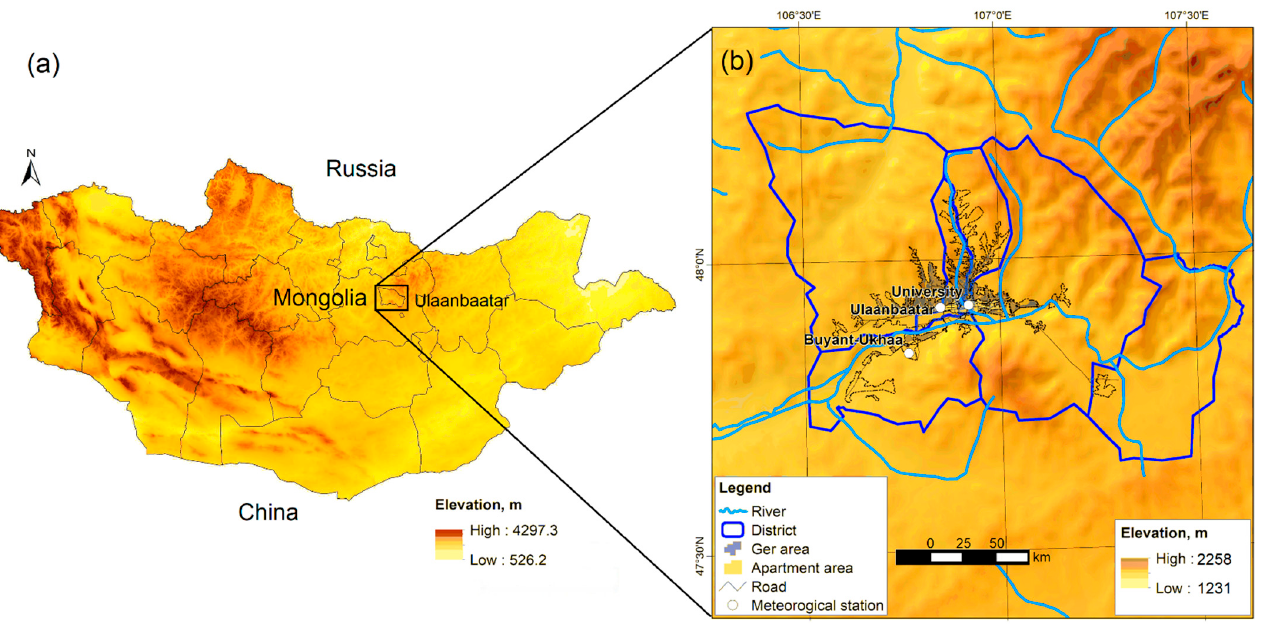
Figure 1. Maps showing location ( a ) and elevation ( b ) of Ulaanbaatar